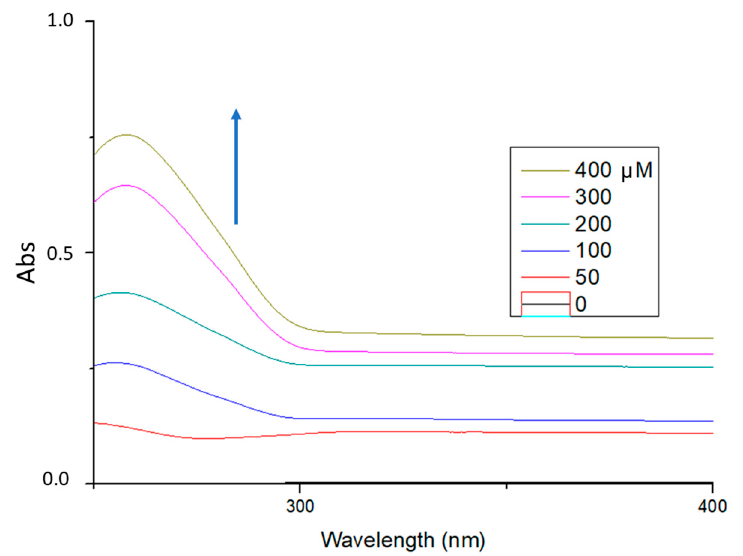
Figure 7. Absorption spectra of the ginger extract (Table 7, entry 1) in Tris-HCl buffer with increasing concentration of ctDNA (0–400 µ M). Arrow refers to hyperchromic (red shift) effect.